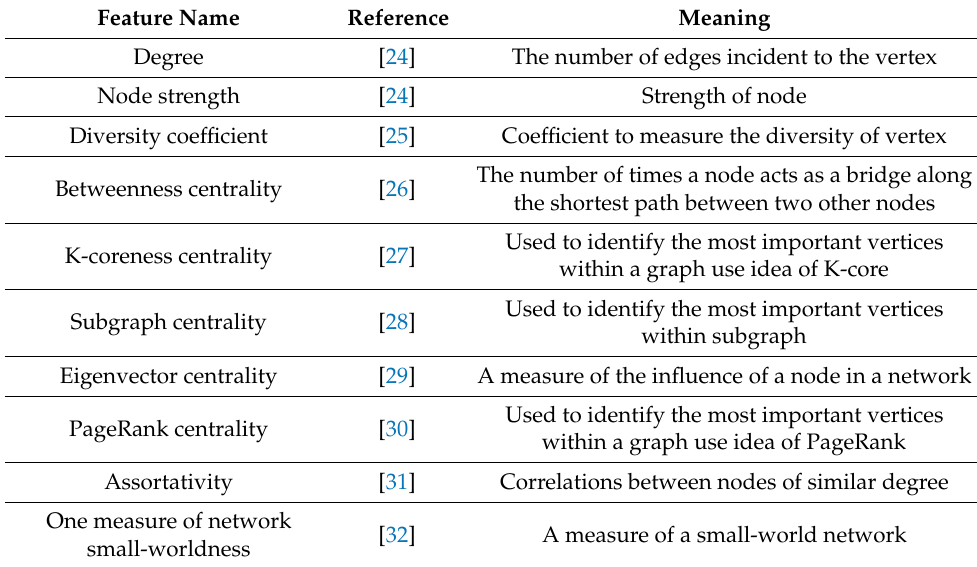
Table 1. 10 graphic features representing the connectivity of